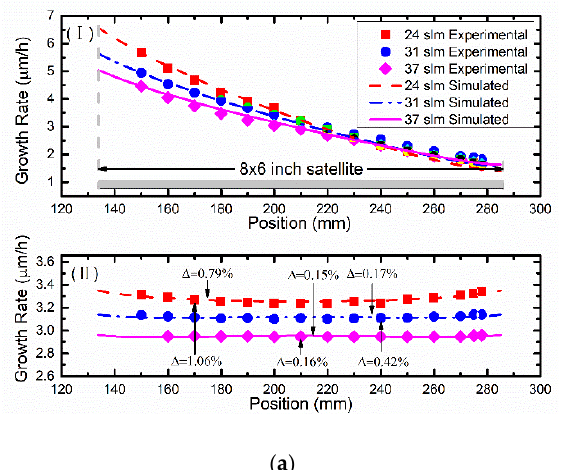
Figure 3. ( a ) Experimental and simulated results of AlGaAs growth rate profiles for various carrier gas flow rates as functions of the susceptor radius r (r = 0 mm for gas inlet at reactor chamber center). (I) Depletion profiles of the static substrates. (II) Growth rate profiles of the rotating substrates. Values for growth rate uniformity are included. ( b ) Simulation results of average growth rate and growth rate uniformity for various carrier gas flow rates on rotating satellites. P = 5 × 10 3 Pa, T growth = 700 °C, total AsH 3 flow rate Q AsH3 = 600 sccm.